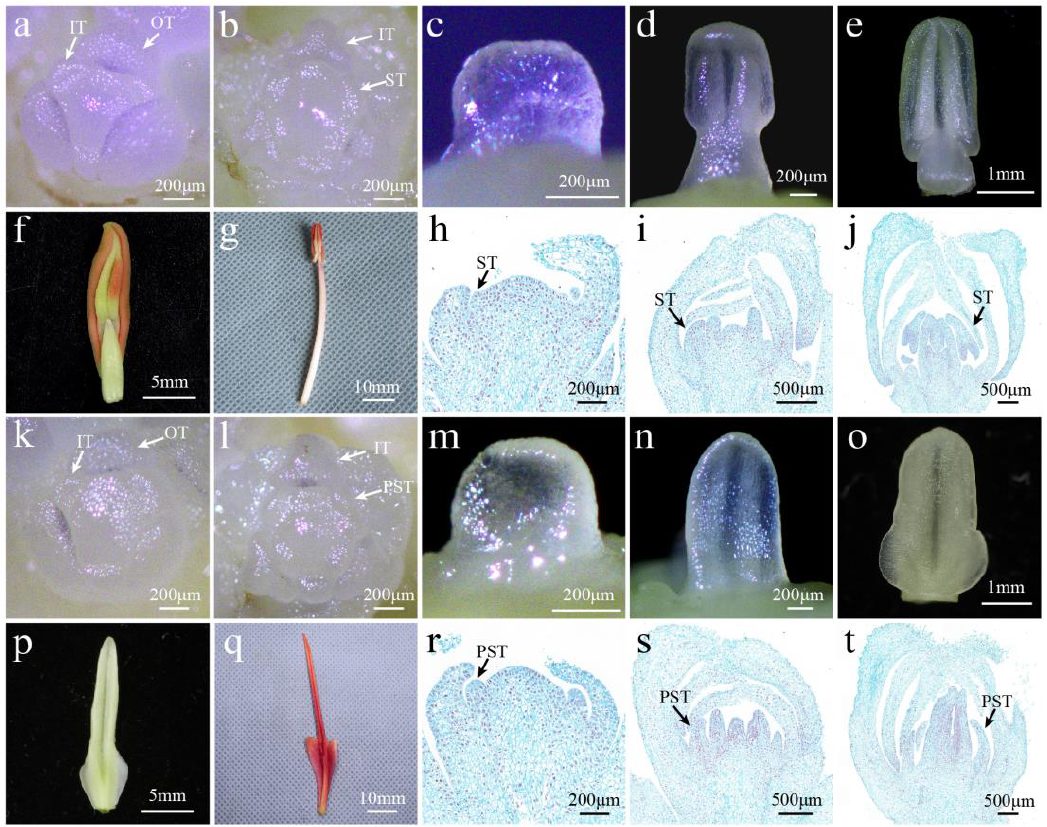
Figure 4. Morphological and cut-section observation of stamens and petaloid stamens in flower buds at different sizes under the temperature treatment of 28 °C and 22 °C, respectively. ( a – j ) 28 °C. ( a ) shows the undifferentiated stamens in flower buds at 0.7 mm. ( b – g ) show the stamens in flower buds at 1 mm, 3 mm, 6 mm, 1 cm, 4 cm, and in the blooming stage, respectively. ( h – j ) show the longitudinal section of stamens in flower buds at 1, 3, and 6 mm, respectively. ( k – t ) 22 °C. ( k ) shows undifferentiated petaloid stamens in flower buds at 0.7 mm. ( l – q ) show the petaloid stamens in flower buds at 1 mm, 3 mm, 6 mm, 1 cm, 4 cm, and in the blooming stage, respectively. ( r – t ) show the longitudinal section of petaloid stamens in flower buds at 1, 3, and 6 mm, respectively. OT, IT, ST, and PST represent outer tepal, inner tepal, stamen, and petaloid stamen, respectively.